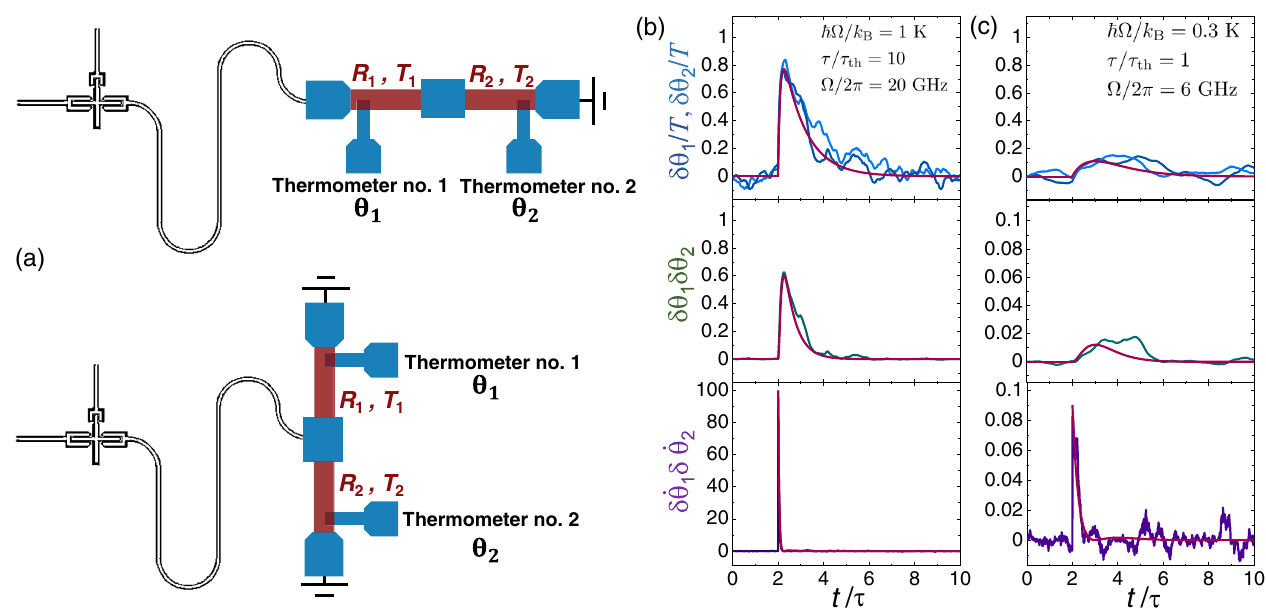
FIG. 5. The proposed cross-correlation setup and numerical results on it. (a) A schematic (not to scale) presentation of a transmon-type superconducting qubit (left), coplanar wave resonator (middle), and the split absorber (right). Each half has its own thermometer, and they are thermally isolated from each other by a superconducting connection in between. Here, blue refers to the superconductor and brown to normal metal. We present two alternative options of splitting the absorber, a series connection (top) and parallel connection (bottom), with essentially the same characteristics in detection. (b),(c) Time-dependent temperature of the two thermometers θ , in i 10 ) in (b) and 0.3 K photon with a somewhat slower thermometer response to 1 K photon with a realistic thermometer ( τ = τ th ¼ _ θ _ θ 1 ) in (c). The results of the two types of correlation measurements, θ θ ( τ = τ 1 ð t Þ 2 ð t Þ and especially 1 ð t Þ 2 ð t Þ , demonstrate how the th ¼ absorption signal can be resolved even in the presence of inevitable thermal noise. The smooth (red) curves in all panels are analytical ¯ θ results excluding the noise, originating from in Eq. i